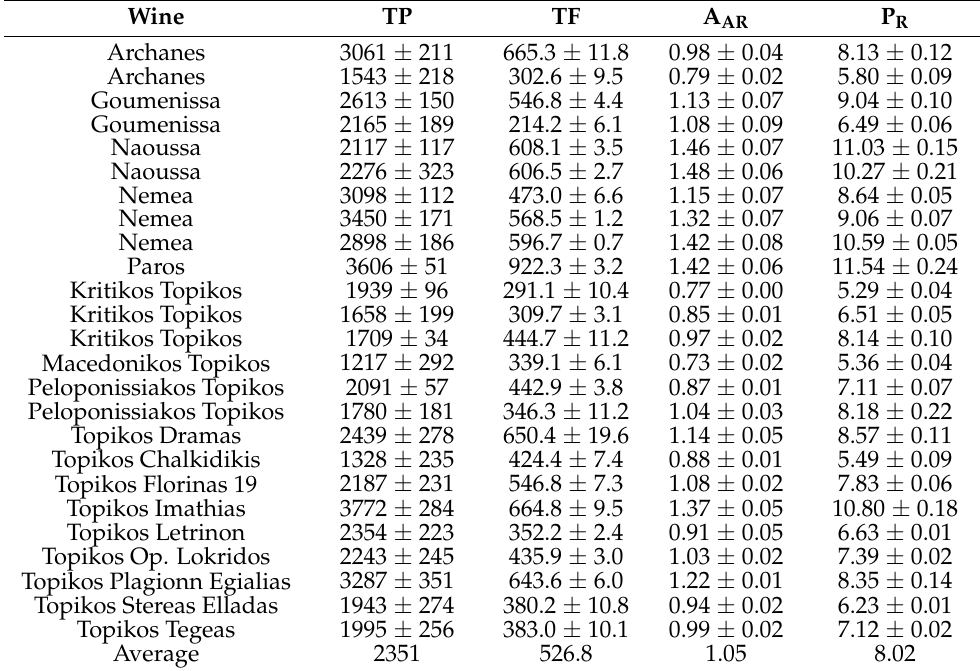
Table 3. Polyphenolic composition and antioxidant parameters of the wines tested ( n = 3) [23].